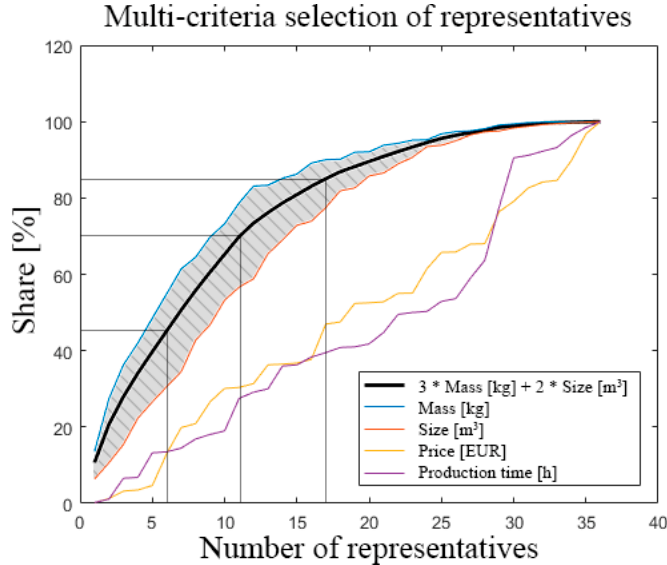
Figure 9. Simulation of a descending distribution of representatives based on two criteria with different weights.